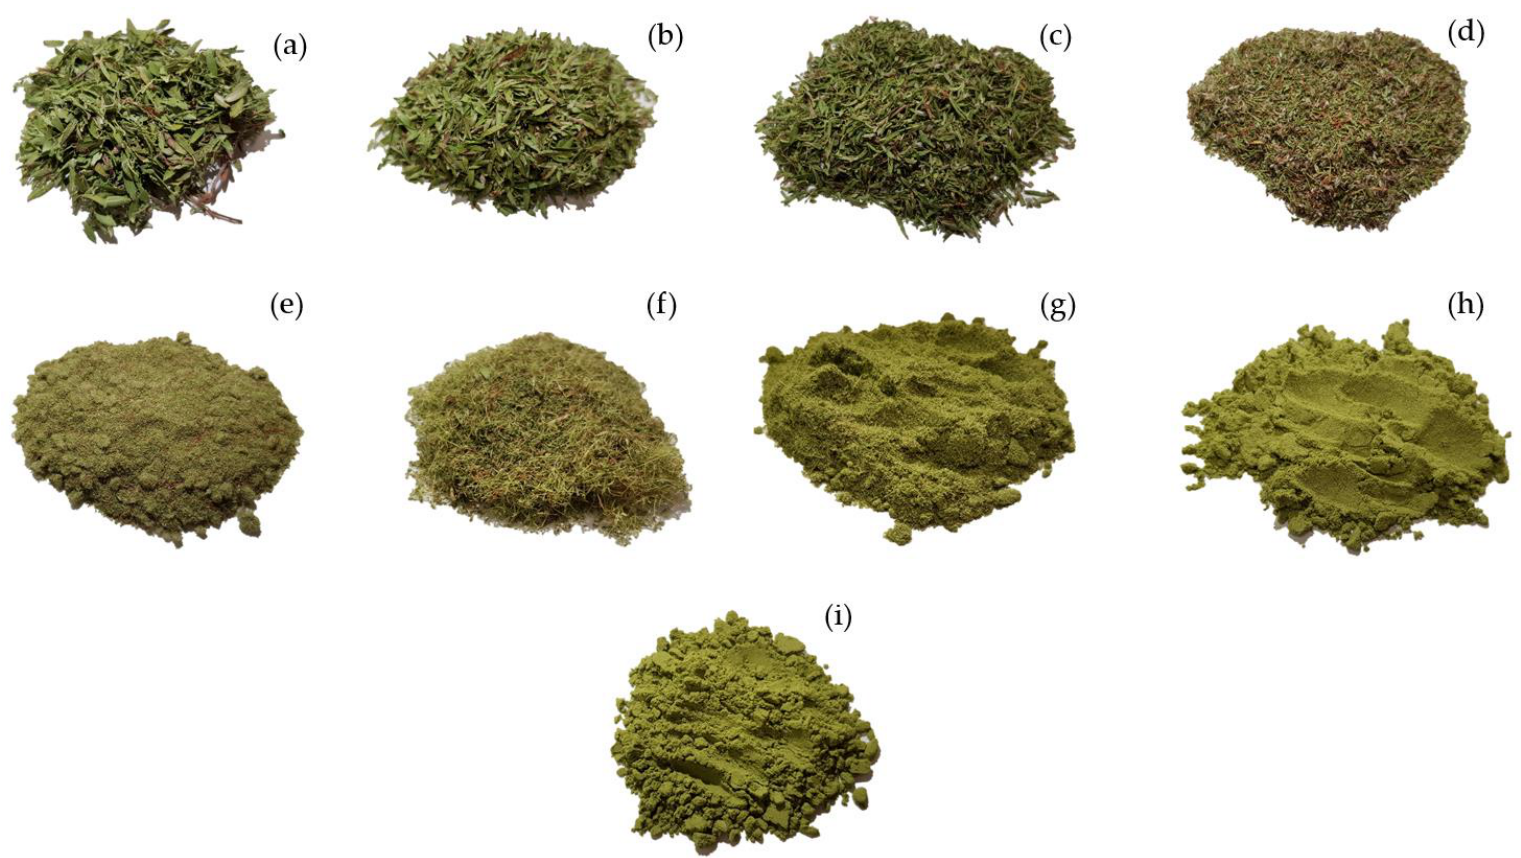
Figure 1. New Zealand Manuka leaves and their corresponding leaves grounded to different particle size: ( A ) 1400 µm, ( B ) 850 µm, ( C ) 500 µm, ( D ) d ≥ 250 µm, ( E ) d ≤ 250 µm, ( F ) d ≥ 200 µm, ( G ) d ≤ 200 µm, ( H ) 100 µm, ( I ) 68 µm.